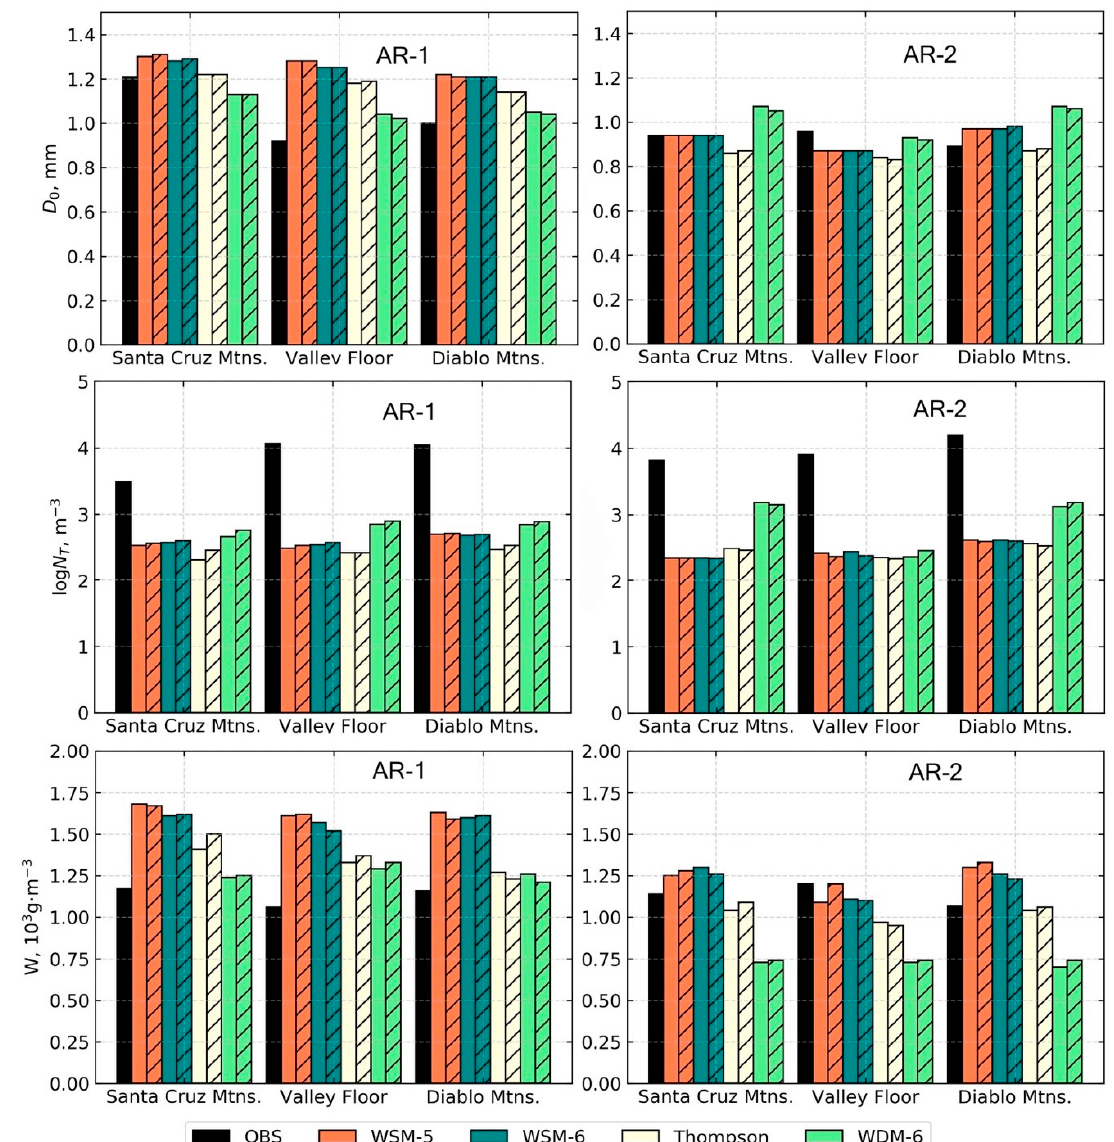
Figure 11. Radar-derived median drop size ( D 0 ), number concentration ( logN T ), and water content ( 𝑊 ). Hatched bars are the 1/3 km model.